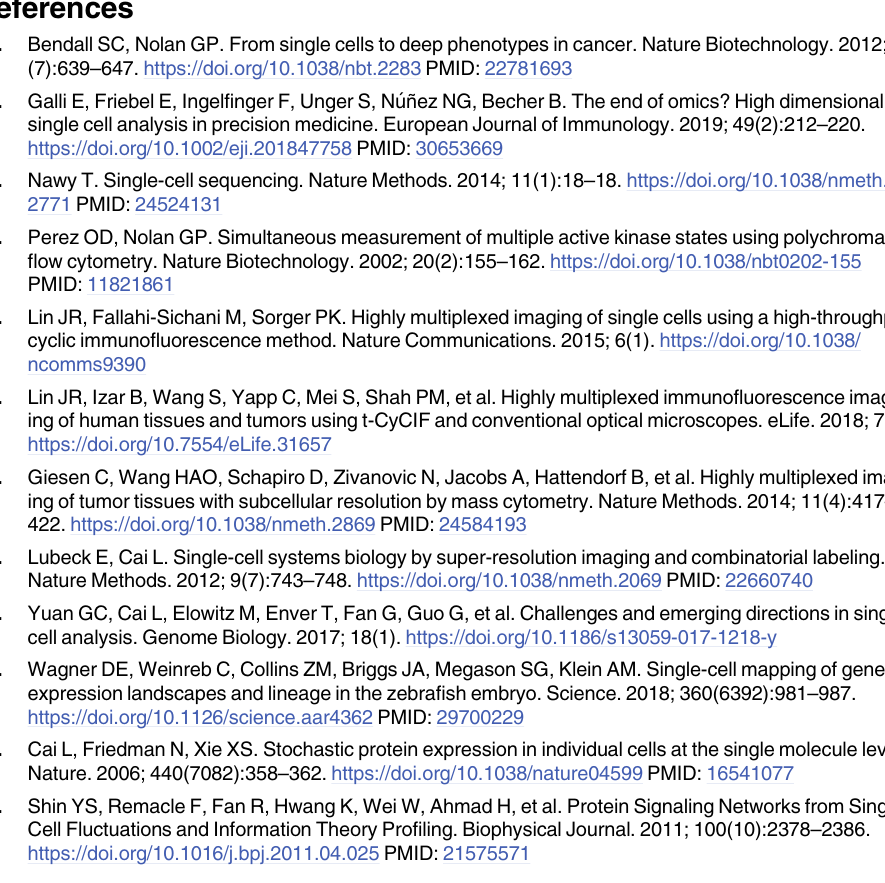
S1 Data. Simulation parameters and reaction networks for Fig 3.